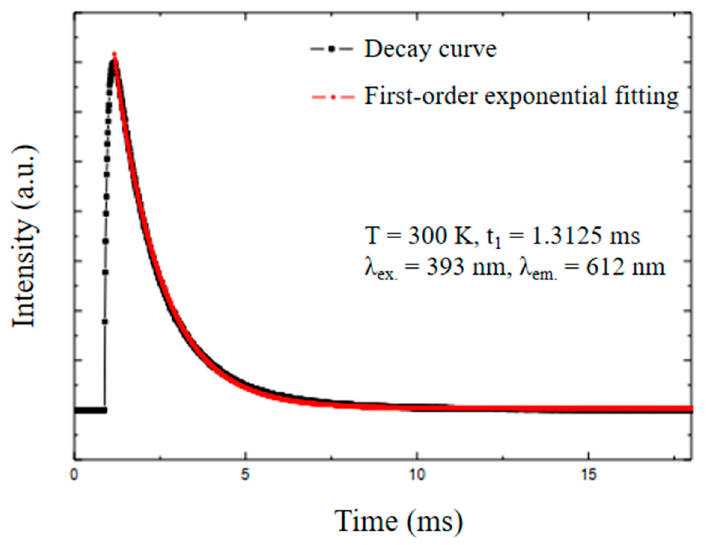
Figure 14. Photoluminescence decay of the Gd 2 O 3 :Eu 3+ nanoparticles, indicating the emission lifetime of this material.